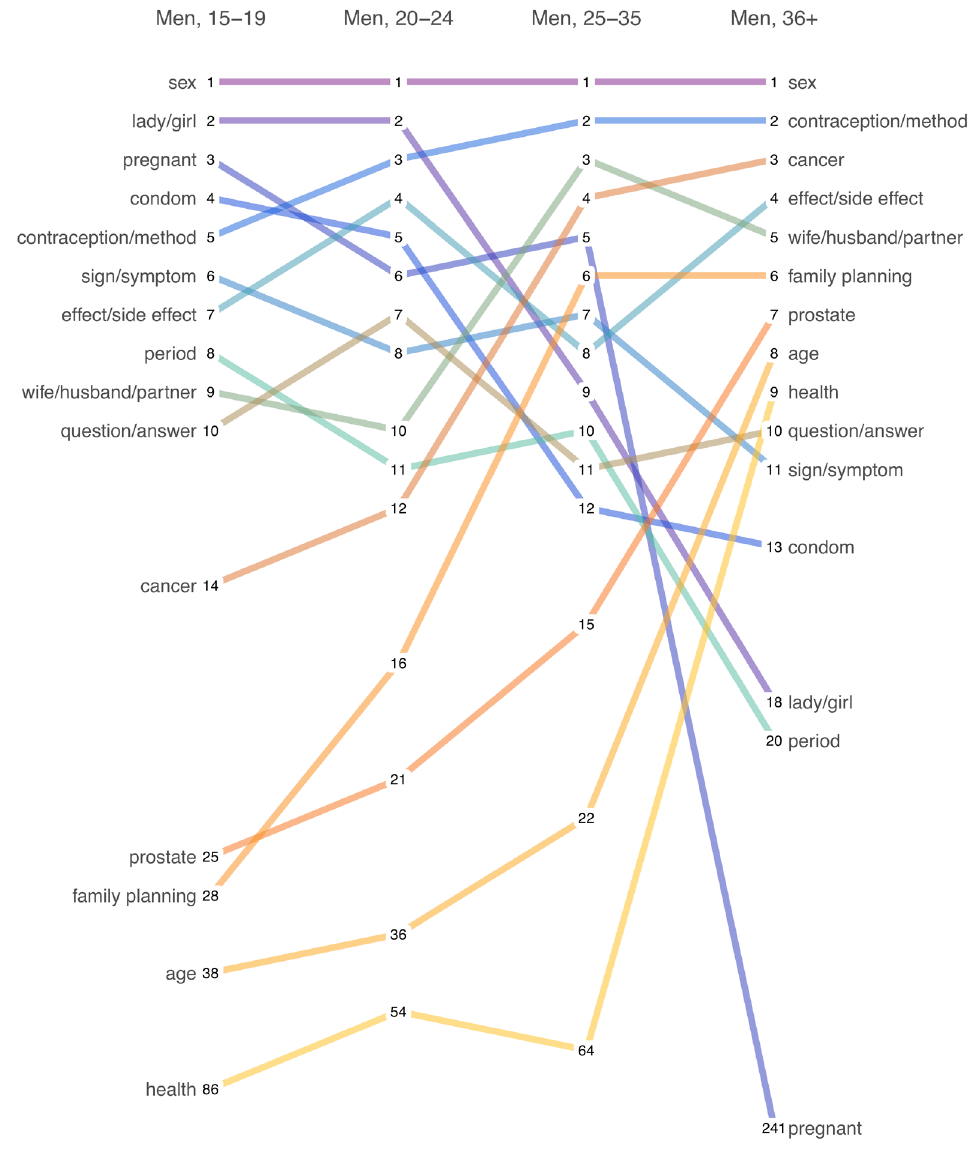
Figure 5. Rank order of the most common words used in incoming messages (English) by age category, men. This is a forced-rank chart because two words could have the same frequency of usage, but no ties are awarded.